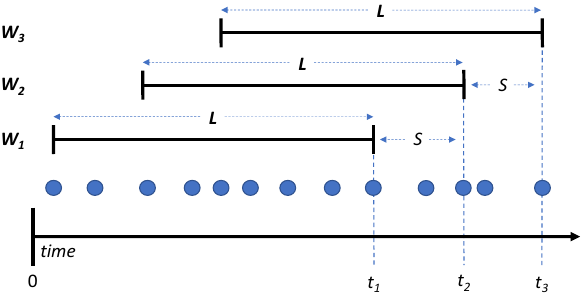
Figure 5. Example of sliding windows with a sliding step of S = 2 events.